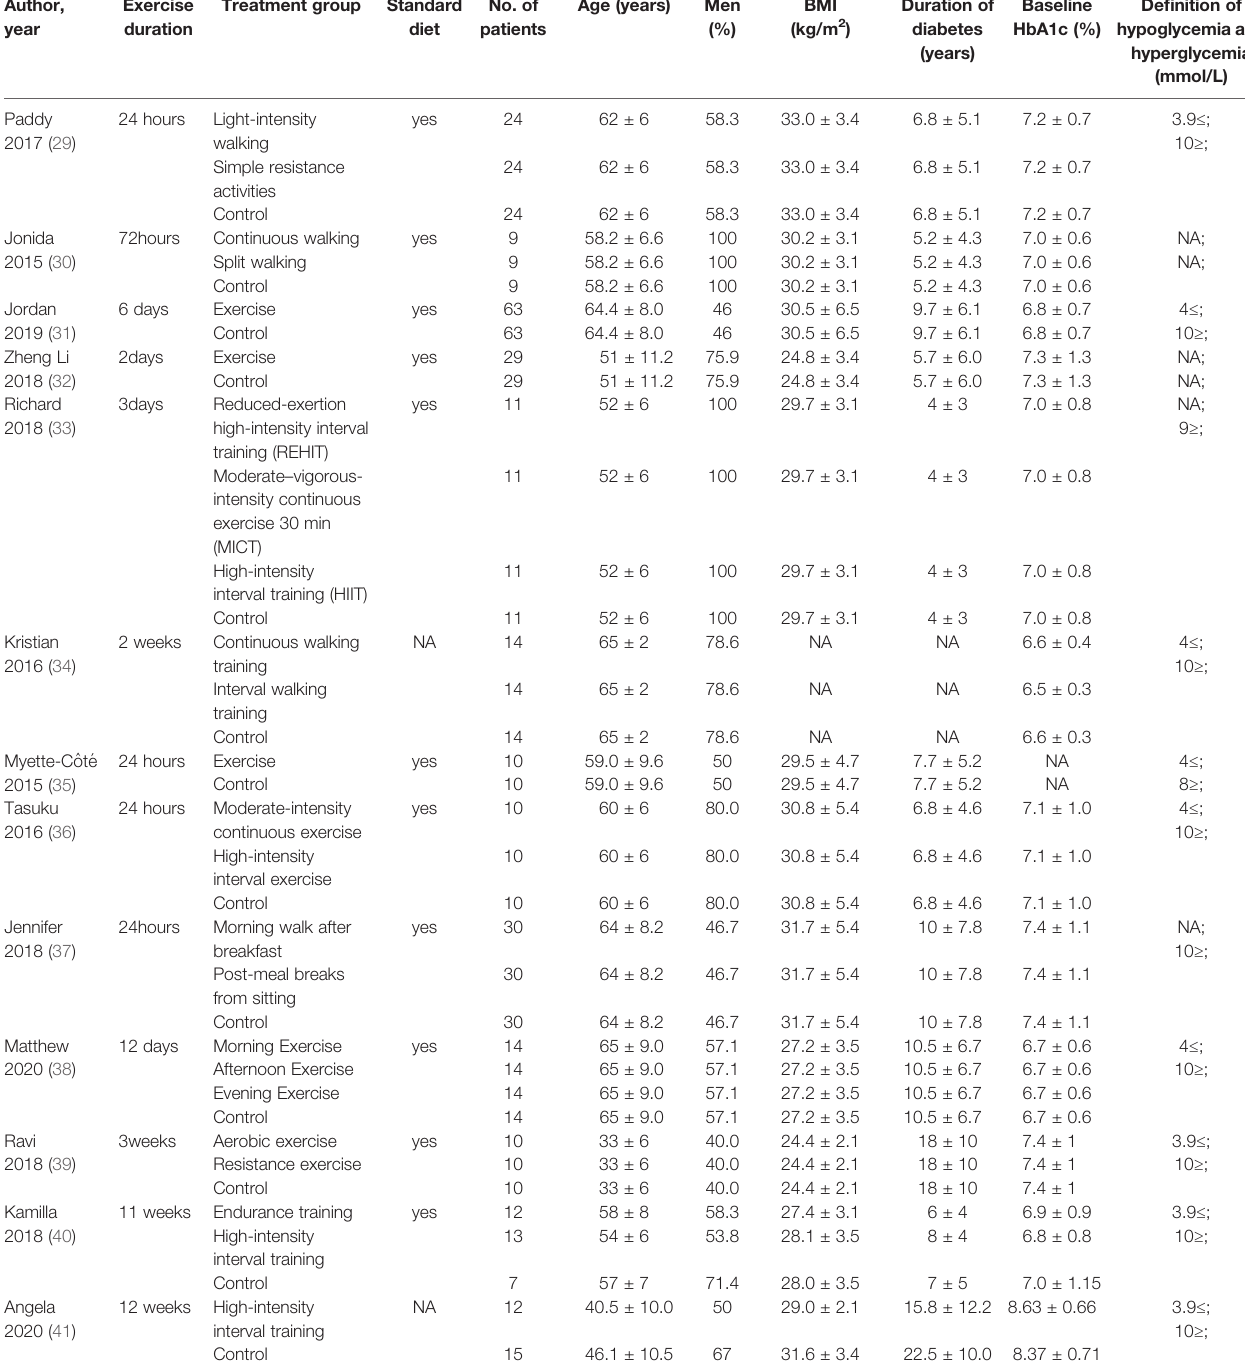
TABLE 1 | Baseline characteristics of each included random controlled